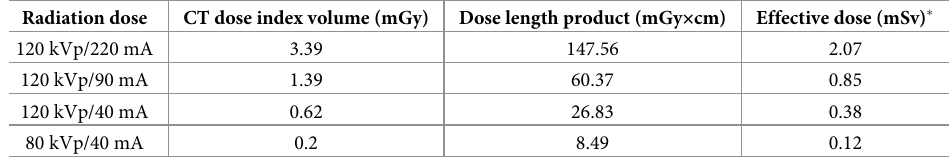
Table 2. Summary of the study protocol and radiation dose data. Radiation